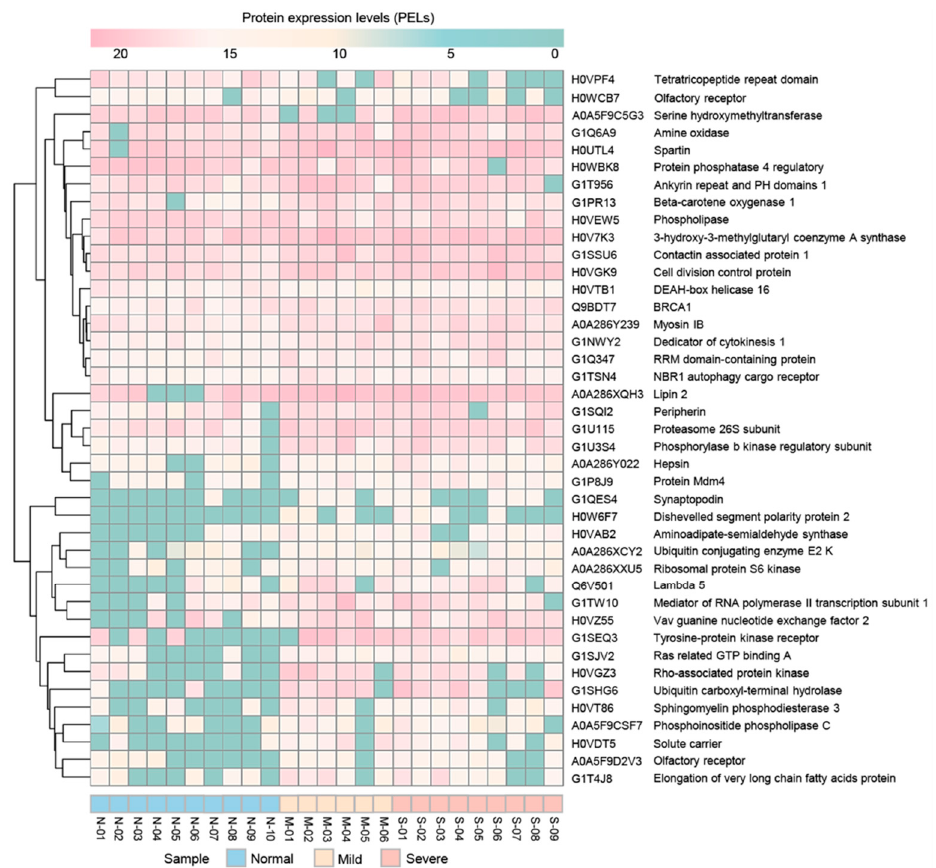
Figure 2. Results for comparative protein expression of the groups with normal, mild and severe EMN. The heatmap was generated using the pheatmap package (https://cran.r-project.org/web/packages/pheatmap/pheatmap.pdf accessed on 4 January 2019), applied in R (version3.5.3, R Foundation for Statistical Computing, Vienna, Austria.) (http://www.R- project.org accessed on 4 January 2019) for conception. N, M and S represent normal, mild and severe EMN, respectively. Table 3. List of 41 significant proteins and associated functions across EMN stages.